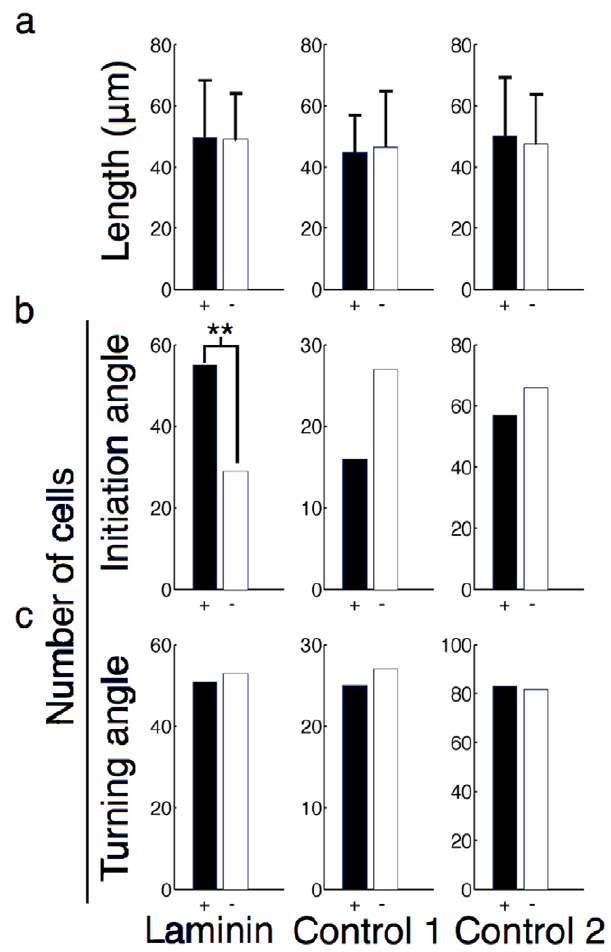
Figure 4. Various parameters of cells extending neurites on high-slope gradients 1 hour after differentiation. (a) The length of the neurite associated with the most distant end-point was similar for attracted and repulsed cells (p=0.798 by t-test). (b) The histogram of the initiation angles of the neurites indicates that the angle at which they sprouted from the soma was responsible for the guidance (p=0.005 by x 2 ). (c) The histogram of the turning angle shows that turning while the neurite was extending was not responsible for guidance.